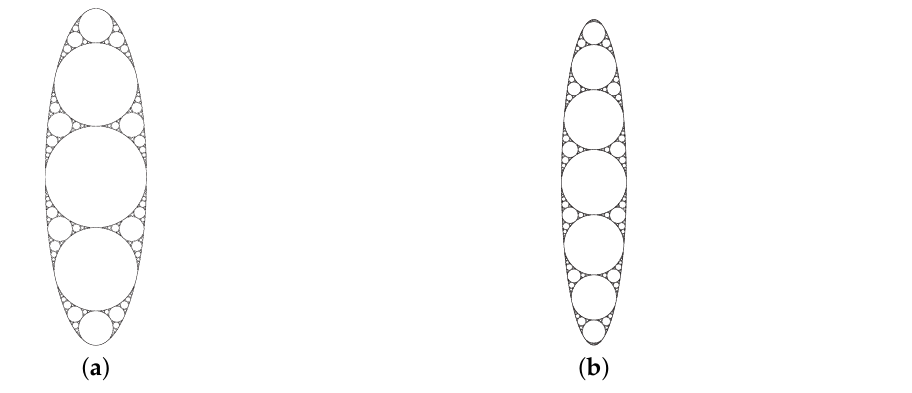
Figure 7. Apollonian packing for a / b =